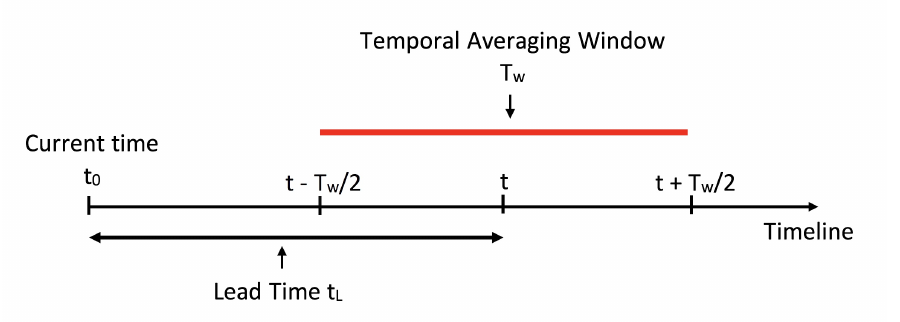
Figure 1. Definition of the time-averaging window as a “centered” window, extending from t − T w /2 to t + T w /2. The horizontal axis represents forecast time from the initial condition at t 0